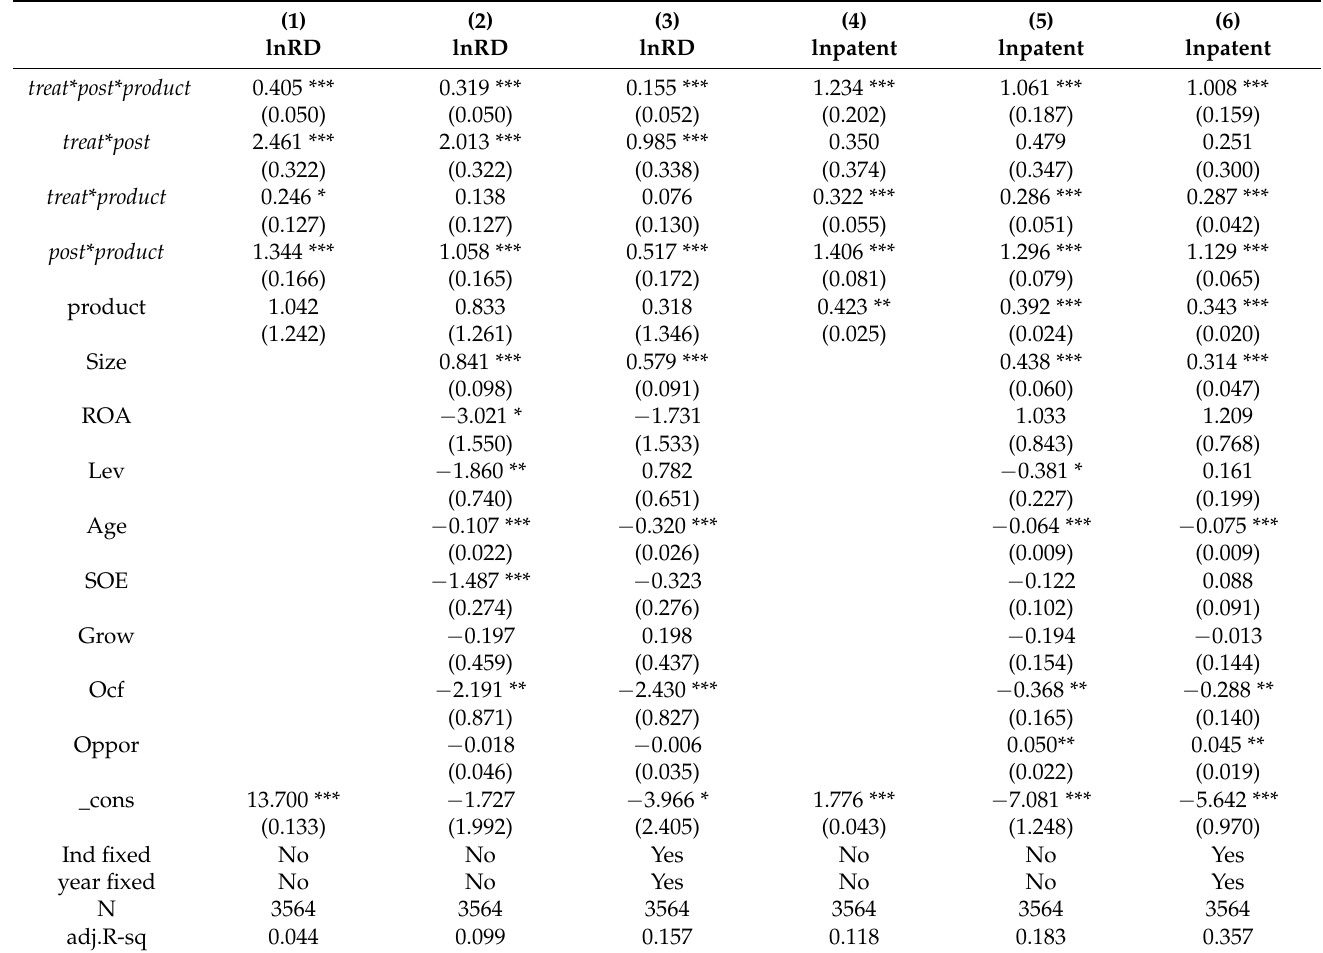
Table 6. The moderating effect of the carbon financial derivatives in the carbon